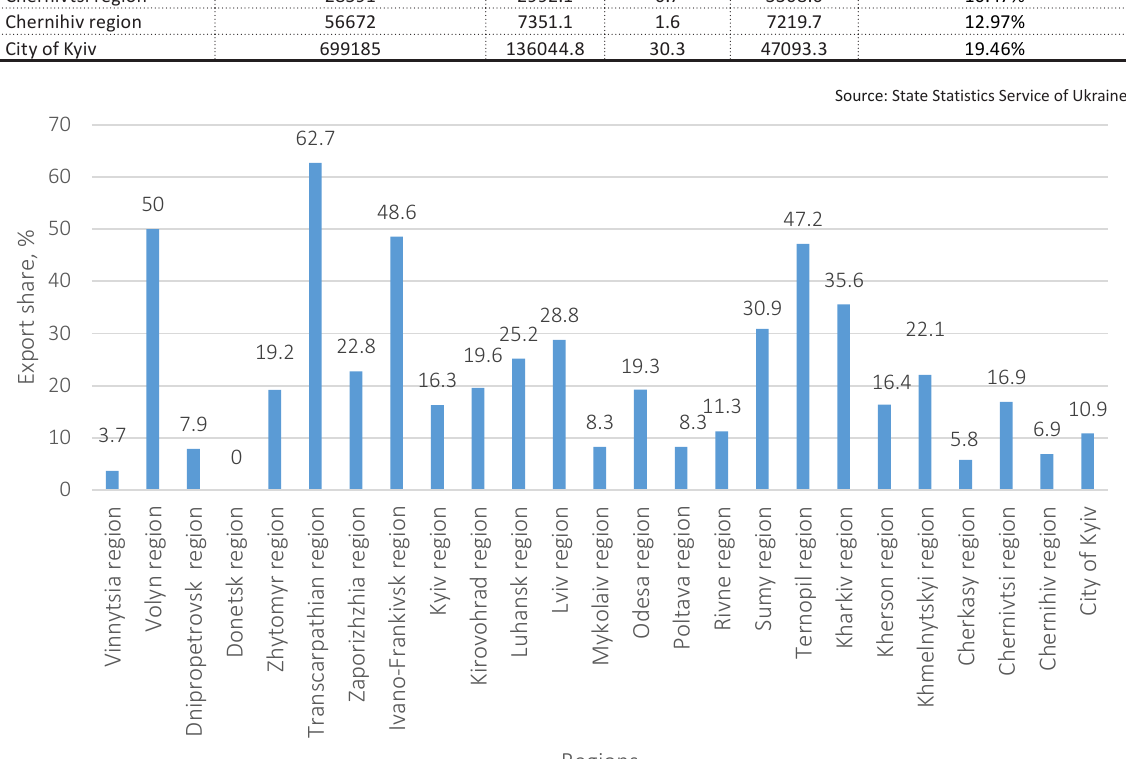
Figure 2. Indicators of assessment of the export and innovation component of the economic potential of the territories of Ukraine in 2017 (the share of exports of goods using high- and medium- high-level technologies in the production of total exports of goods,